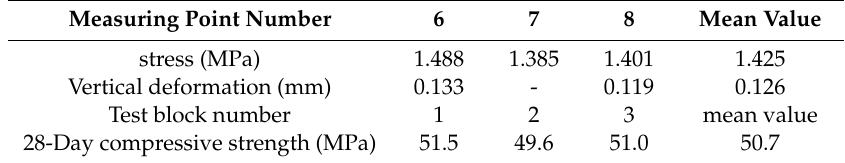
Table 5. Stress and deformation during the loading process and the 28-day compressive strength.